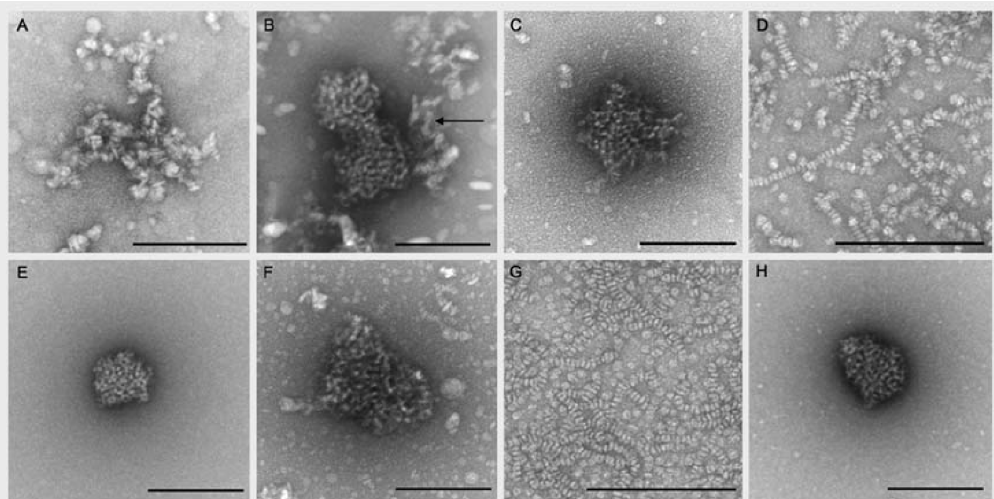
Figure 13. TEM images of diverse samples. ( A ) β -aescin micelles in water. ( B – H ): Pseudo-ternary and pseudo-binary systems prepared by the lipid film hydration method with aqueous solution. ( B , C